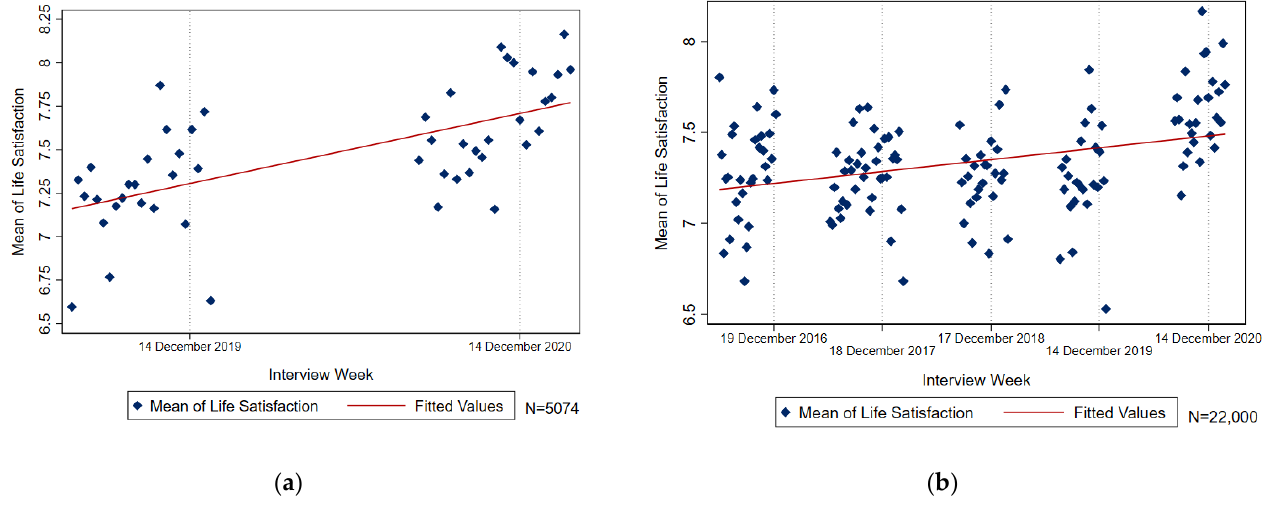
Figure 1. ( a ) Mean of life satisfaction in 2019 and 2020 by interview week, consistent panel; ( b ) mean of life satisfaction from 2016 to 2020 by interview week, all observations.